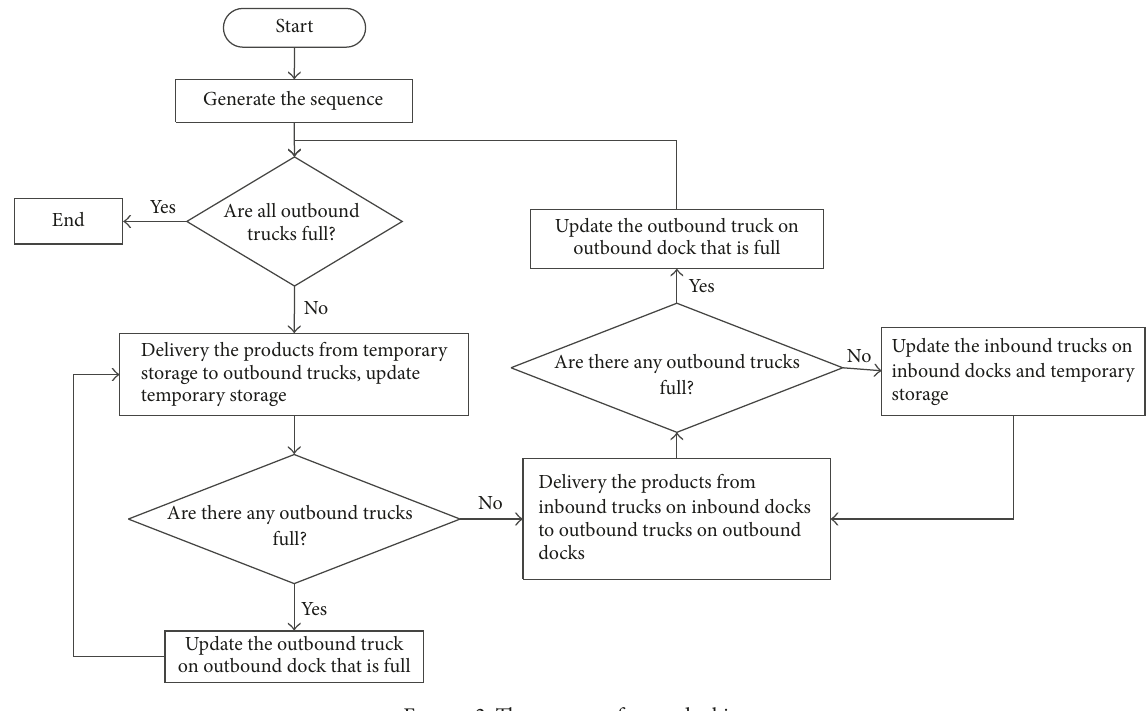
Figure 2: The process of cross docking.